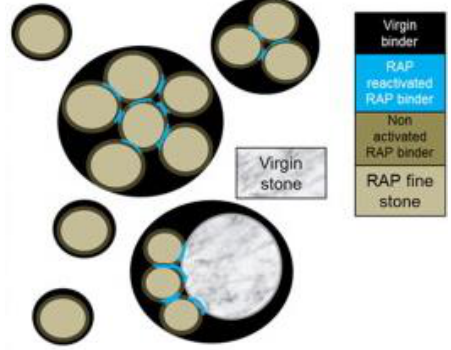
Figure 1. Schematic diagram of cluster phenomenon [15].